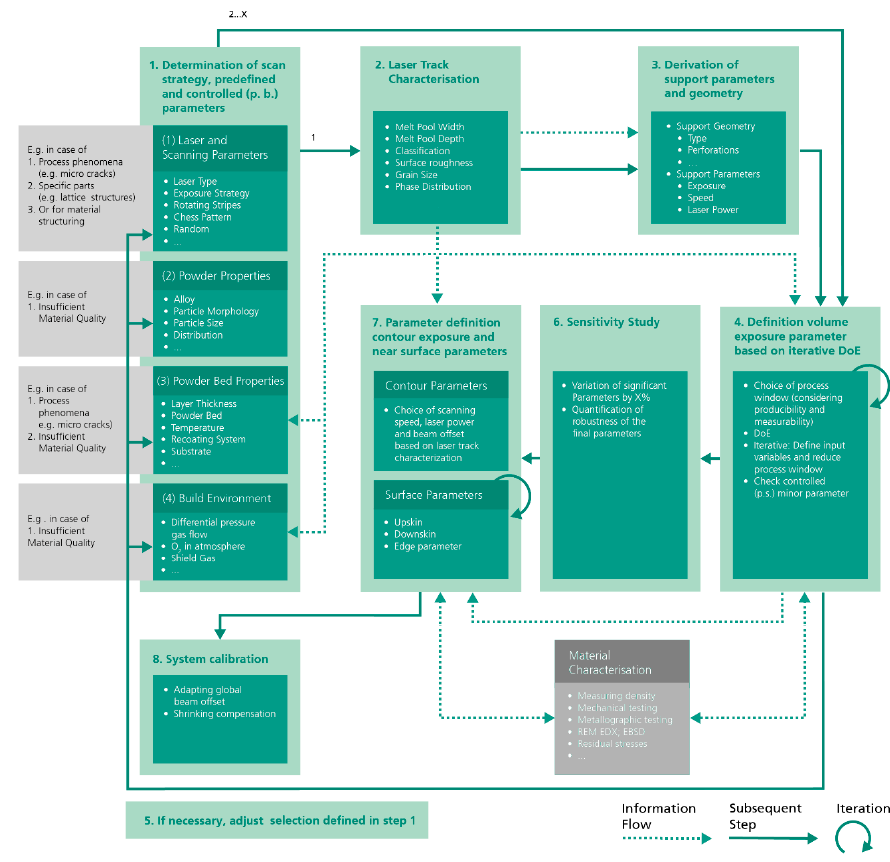
Figure 3. Schematic design of the proposed approach.